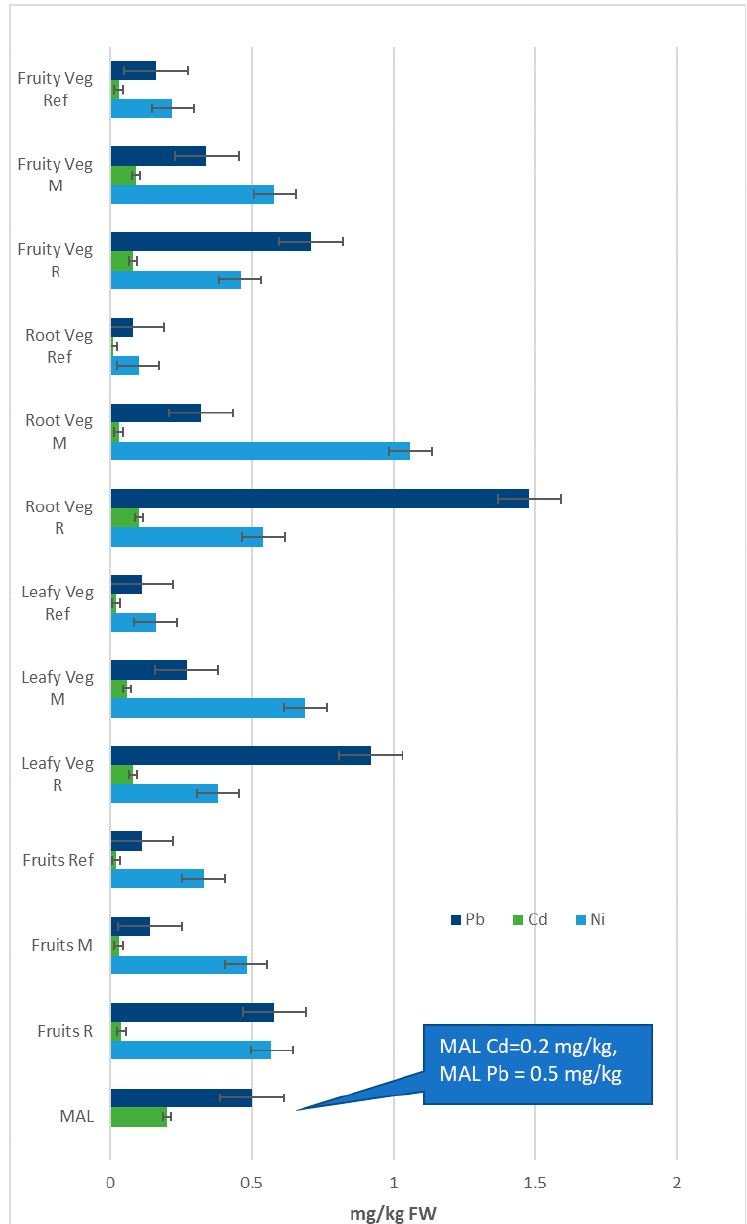
Figure 3. Concentrations of Ni, Cd and Pb (mg/kg FW) in different groups of vegetal